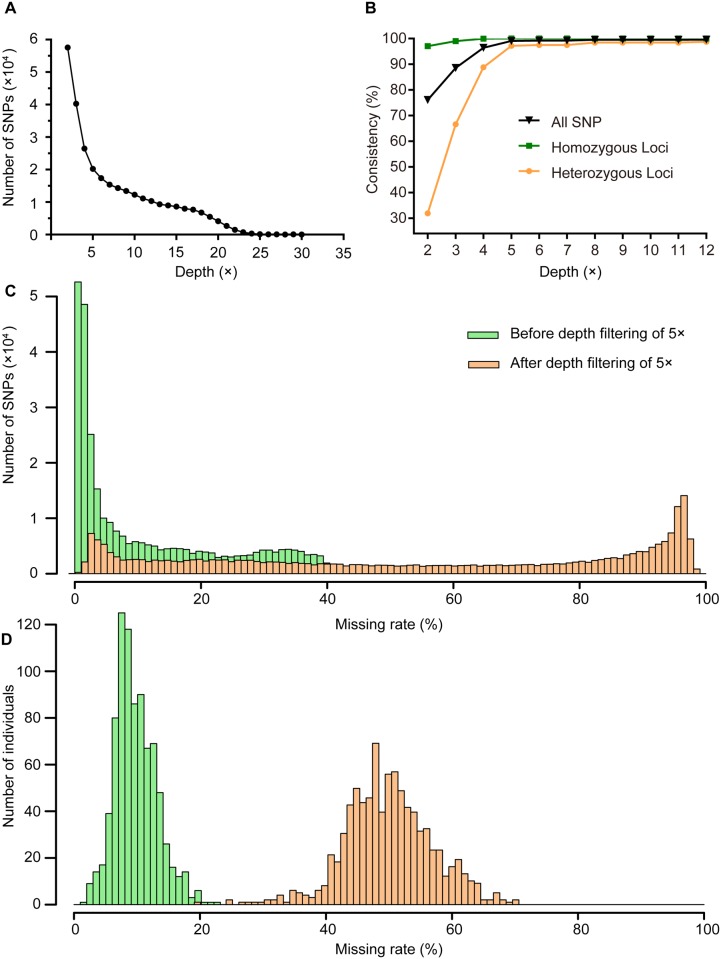
Genotyping accuracy evaluation according to different sequencing depths.A) Distribution of coverage depths for all SNPs. B) Consistency of ddGBS genotyping results compared with 60K BeadArray microarrays using various filter conditions (sequencing depth ranging from 2× to 12×). C) Comparison of the missing rates of all 292 K SNPs on a per-site basis before and after depth filtering of 5×. D) Comparison of the missing rates of all 824 samples on a per-individual basis before and after depth filtering of 5×.